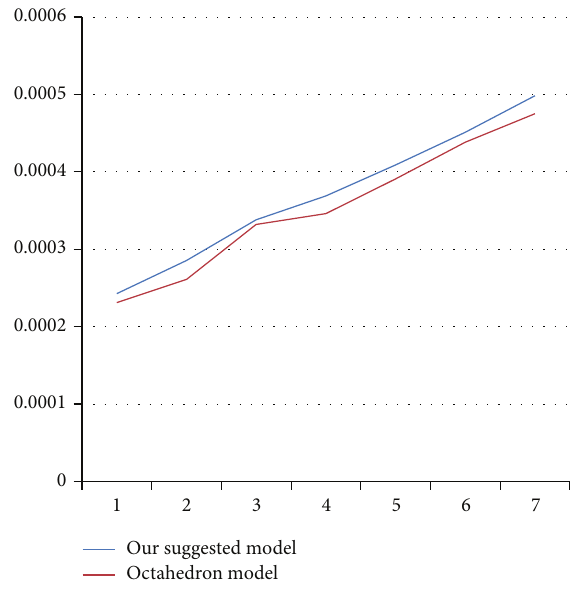
Figure 19: Showing that displacements are almost the